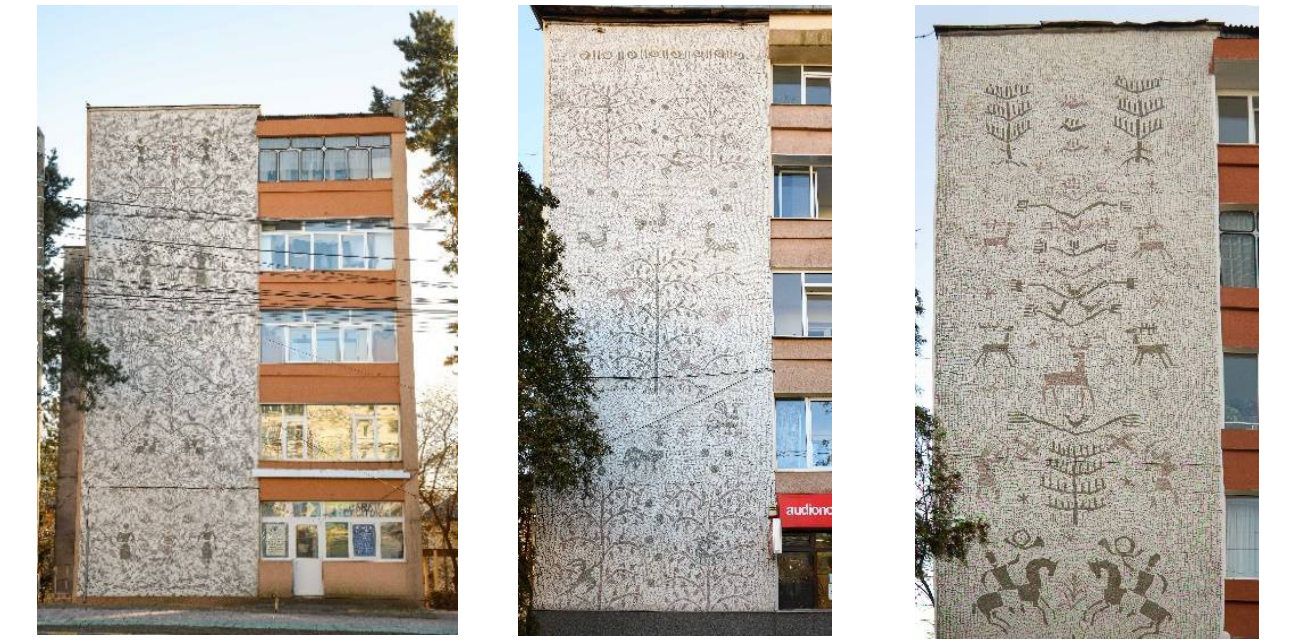
Figure 2. Mosaics on the “H blocks”: “Wedding”, “Forest”, “Hunting”. (Source: Petru Palamar).